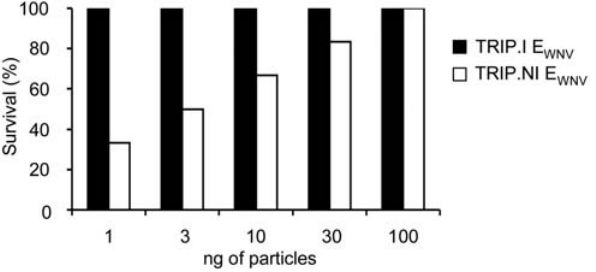
Figure 4. Rapid protection against WNV infection conferred by nonintegrative lentiviral vector immunization. Six mice/group were vaccinated with 100 ng of TRIP.NI E WNV or 100 ng of TRIP.I E WNV . A control group of mice inoculated with phosphate-buffered saline (PBS) was included. One week after the vaccination, mice were challenged with 1,000 i.p. LD 50 s of WNV strain IS-98-ST1. Survival was recorded for 21 days. Data are representative of three independent experiments.